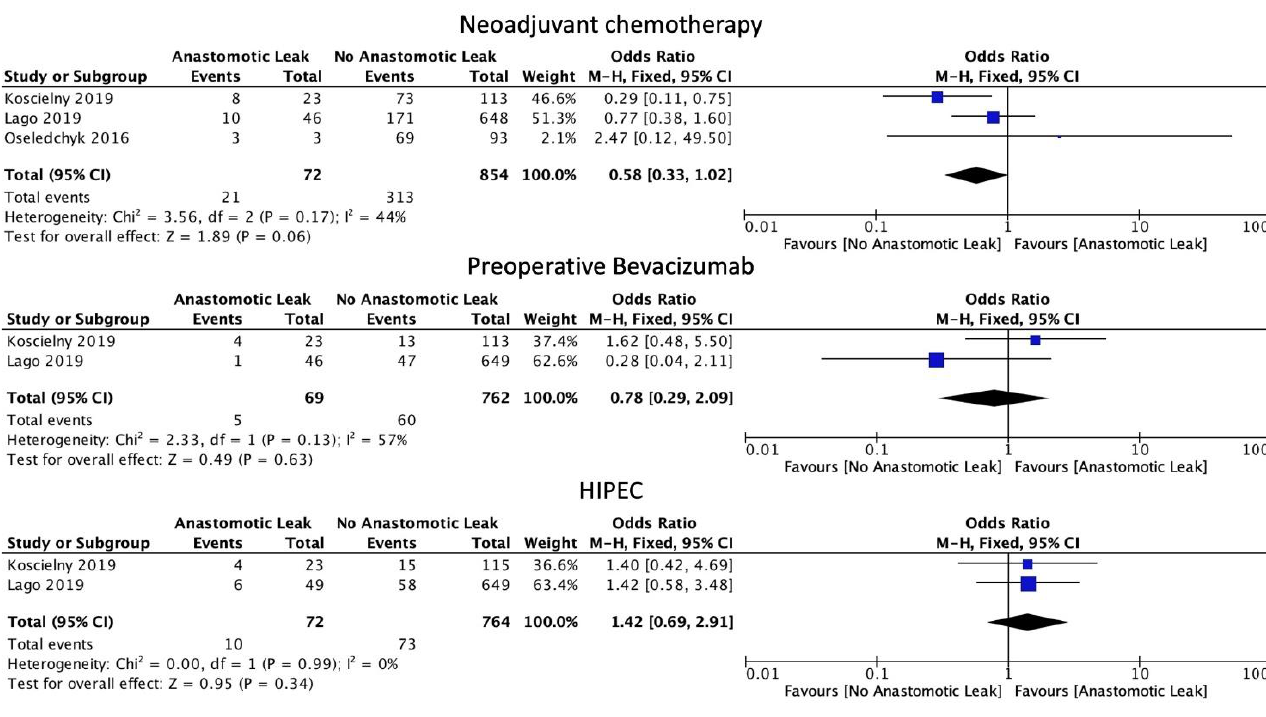
Figure 4. Chemotherapy administration.